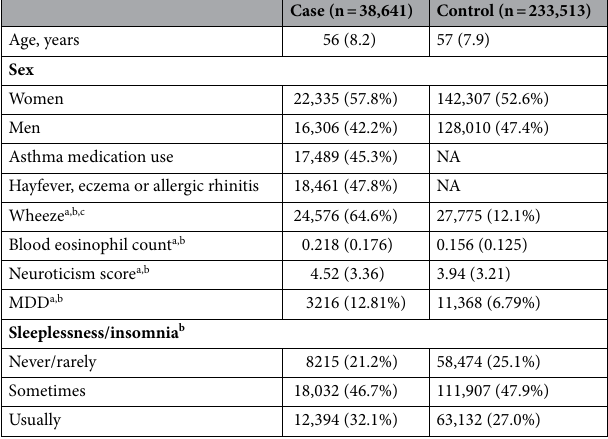
Table 1. Basic characteristics of participants with and without asthma (case and control groups). All data are presented as mean ± standard deviation or numbers (%). NA not applicable, MDD major depressive disorder. a Participants available with this data were analysed. b Significant difference between case and control ( P < 0.01). c Wheezing or whistling in the chest in the last